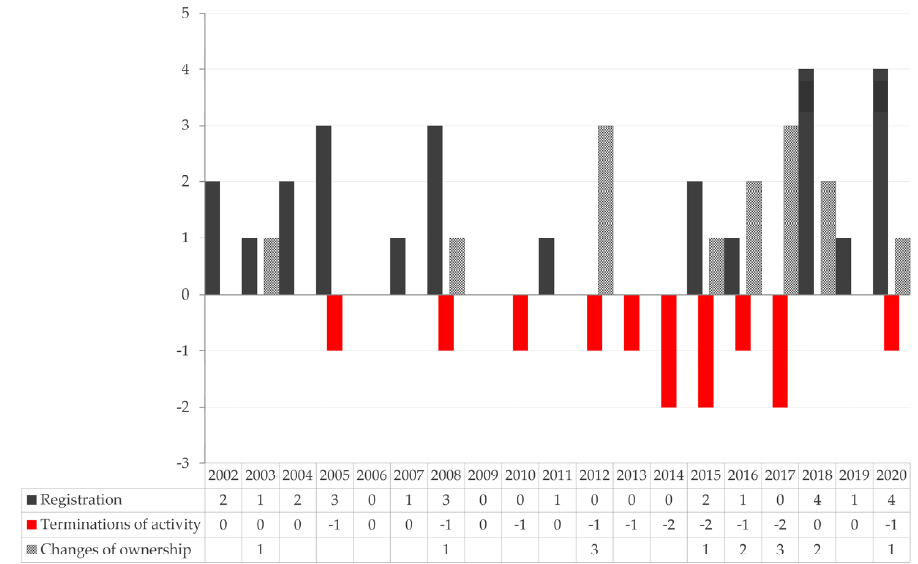
Figure 6. Registrations, terminations of activity, and changes of ownership per year (2002–2020). Source: [80,81,94]. Authors own elaboration.